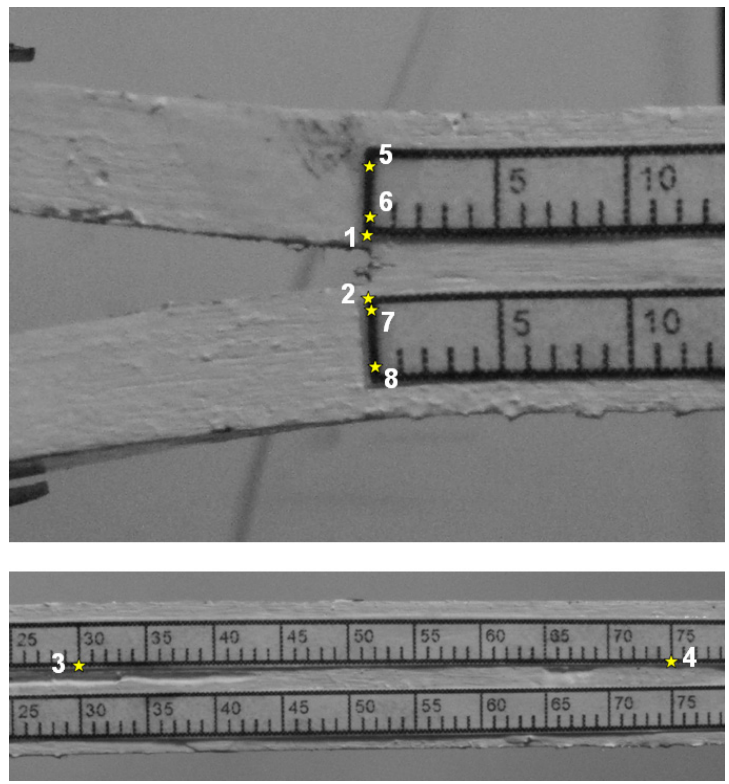
Figure 3: Points taken by the optical method for measuring 